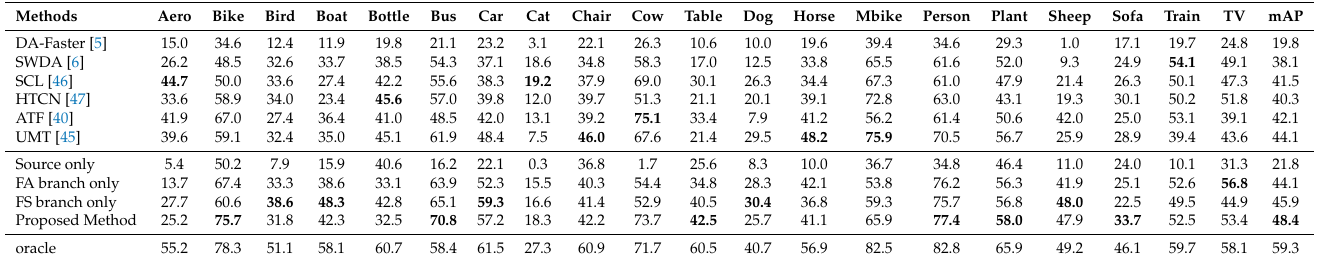
Table 2. The mean Average Precision (mAP) of different models on Clipart val set for Pascal VOC → Clipart transfer. The best results are in